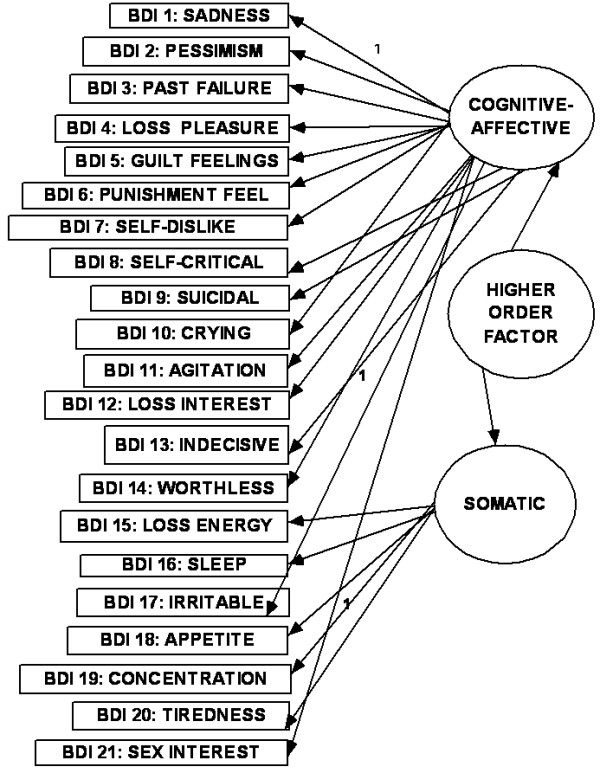
Higher order model.